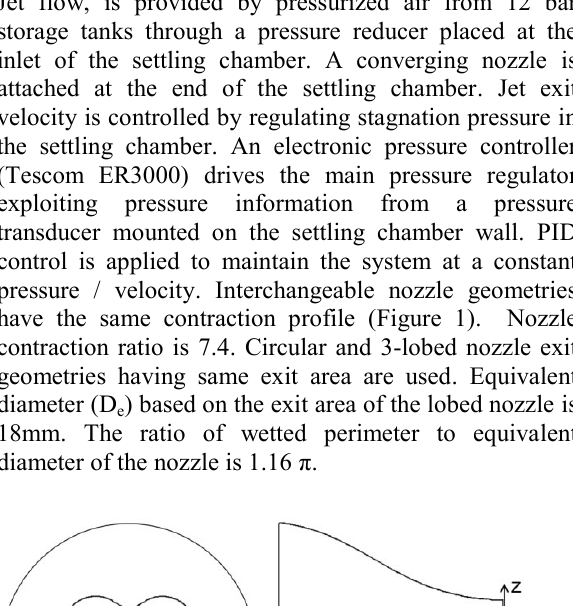
Fig. 2. Probe positioning platform